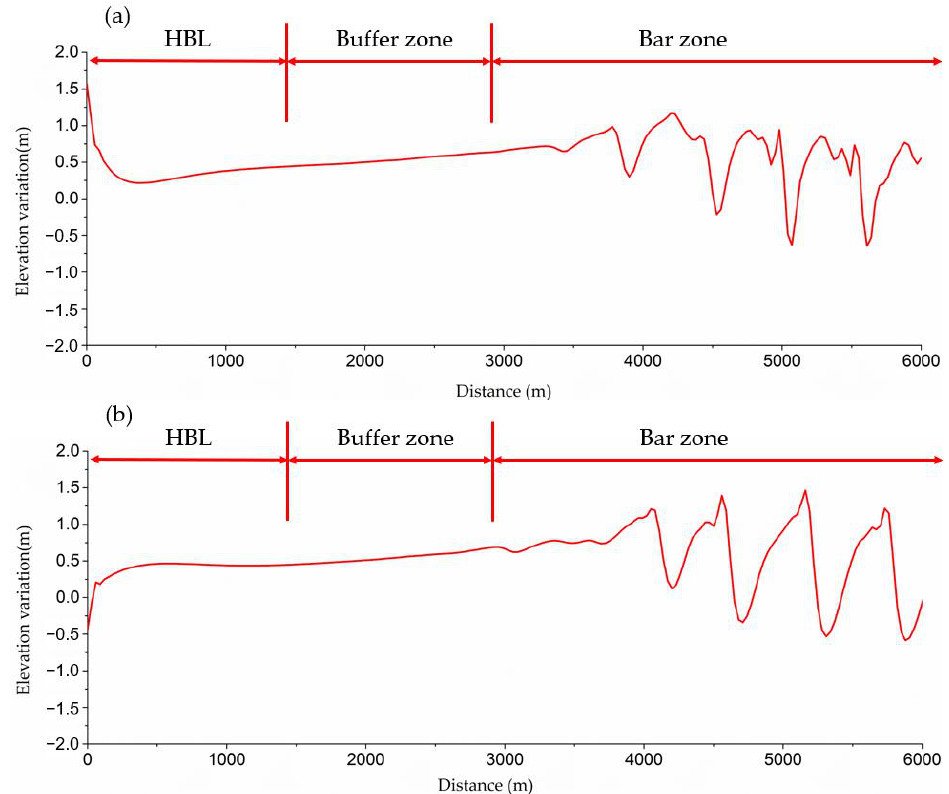
Figure 2. Bed elevation change along the right bank 6000 m upstream after 25 hydrographs in the case of constant sediment feed condition. ( a ) At lowest discharge. ( b ) At peak discharge.